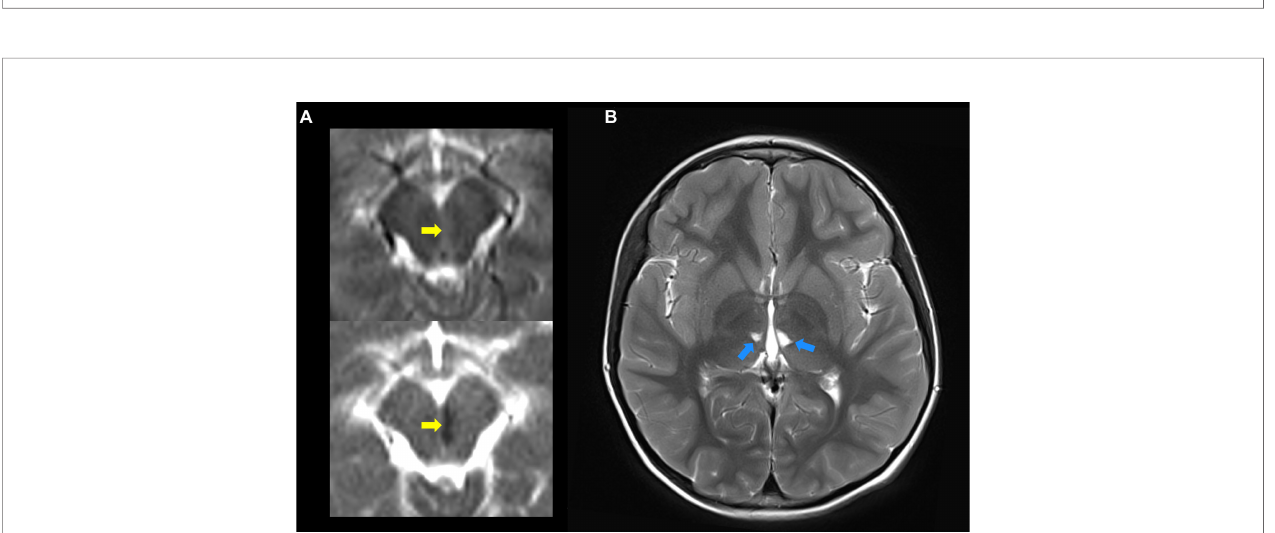
FIGURE 4 | The ischemic strokes in DADA2 may present at an early age and can occur, repeatedly, deep in the brain. (A) Shows the diffusion weighted imaging (DWI) (top) and apparent diffusion coef fi cient (ADC) (bottom) indicative of acute diffusion restriction (yellow arrows) consistent with a new left-paramedial midbrain infarct. (B) The same study, on T2 images a few cuts above, shows evidence of two prior lacunar strokes on the thalamus (blue arrows). These strokes occurred in a 3 year 11-month-old boy.